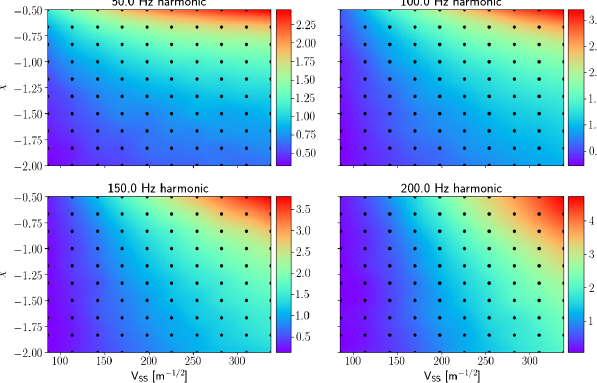
FIG. 17. Interpolated 2D maps of the main harmonics sup- pression factors in the V × ξ scan. The variable χ (normalized ss chromaticity) is defined as ξ =Q 0 , where Q 0 is the nominal machine tune. The color code indicates the ratio between the obtained transfer function value and the nominal one for the considered harmonic component. The black points show the scan grid. The results of Fig. 17 confirm what was expected: higher chromaticity (in absolute value) and weaker sextupole strength increase the attenuation of the slow extraction transfer function.